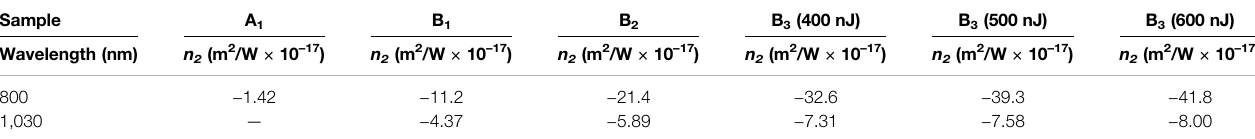
TABLE 2 | Nonlinear refraction index of the A and the B thin fi lms under different excitation conditions.